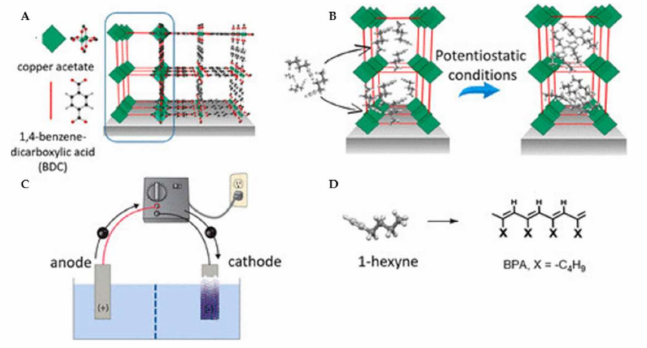
MHDA SAM. ( B ) Schematic showing the polymerization inside the nanochannels of SURMOF-2. ( C )